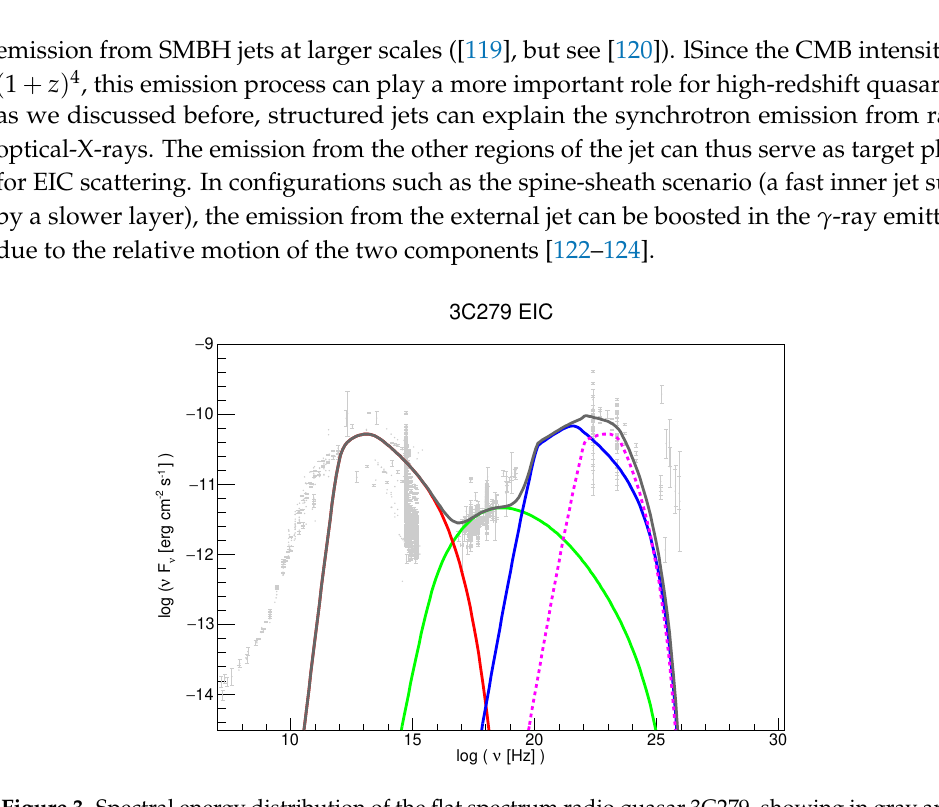
= 50, γ (cid:48) = 10 4 , n = 2.5, = 350, γ (cid:48) 1 Max min break = 1 erg cm − 3 , u (cid:48) = 0.7 erg cm − 3 torus Ly α